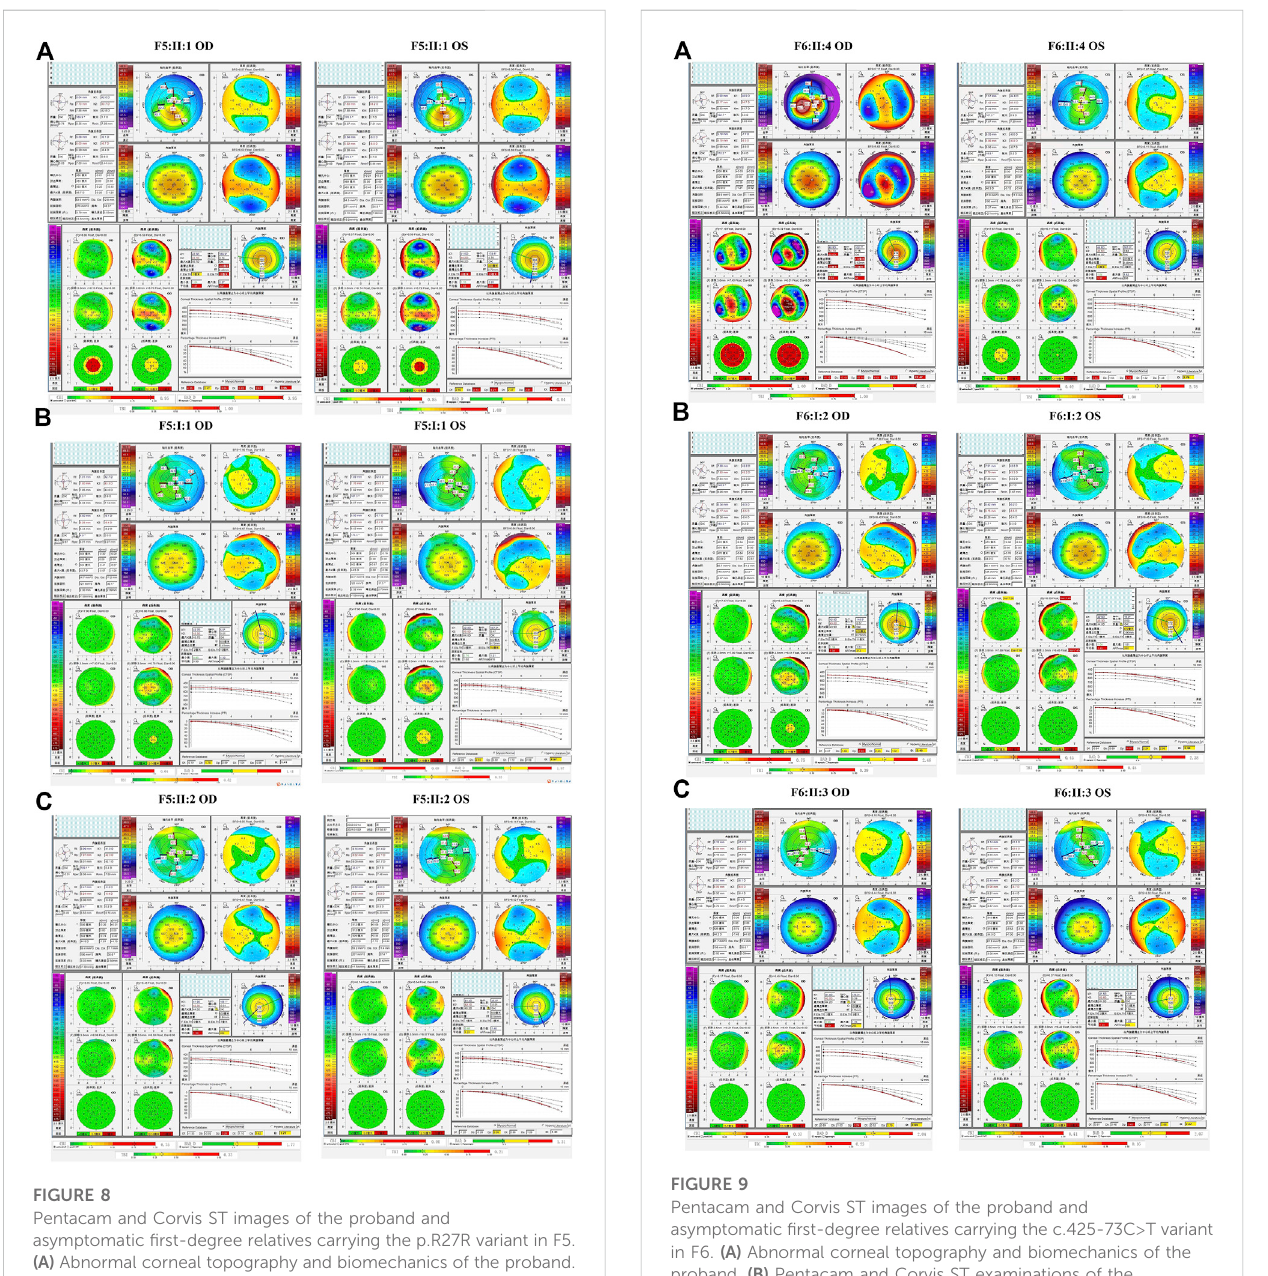
(Eichler et al., 2010). An Italian study of 302KC patients (De Bonis et al., 2011), which is the largest study population reported to date, highlighted the possibility of variable expression and incomplete epistasis of VSX1 sequence variations in KC. Chen et al. (2021) conducted genetic and clinical studies on 88KC families and reported that relatives were at higher risk of developing latent